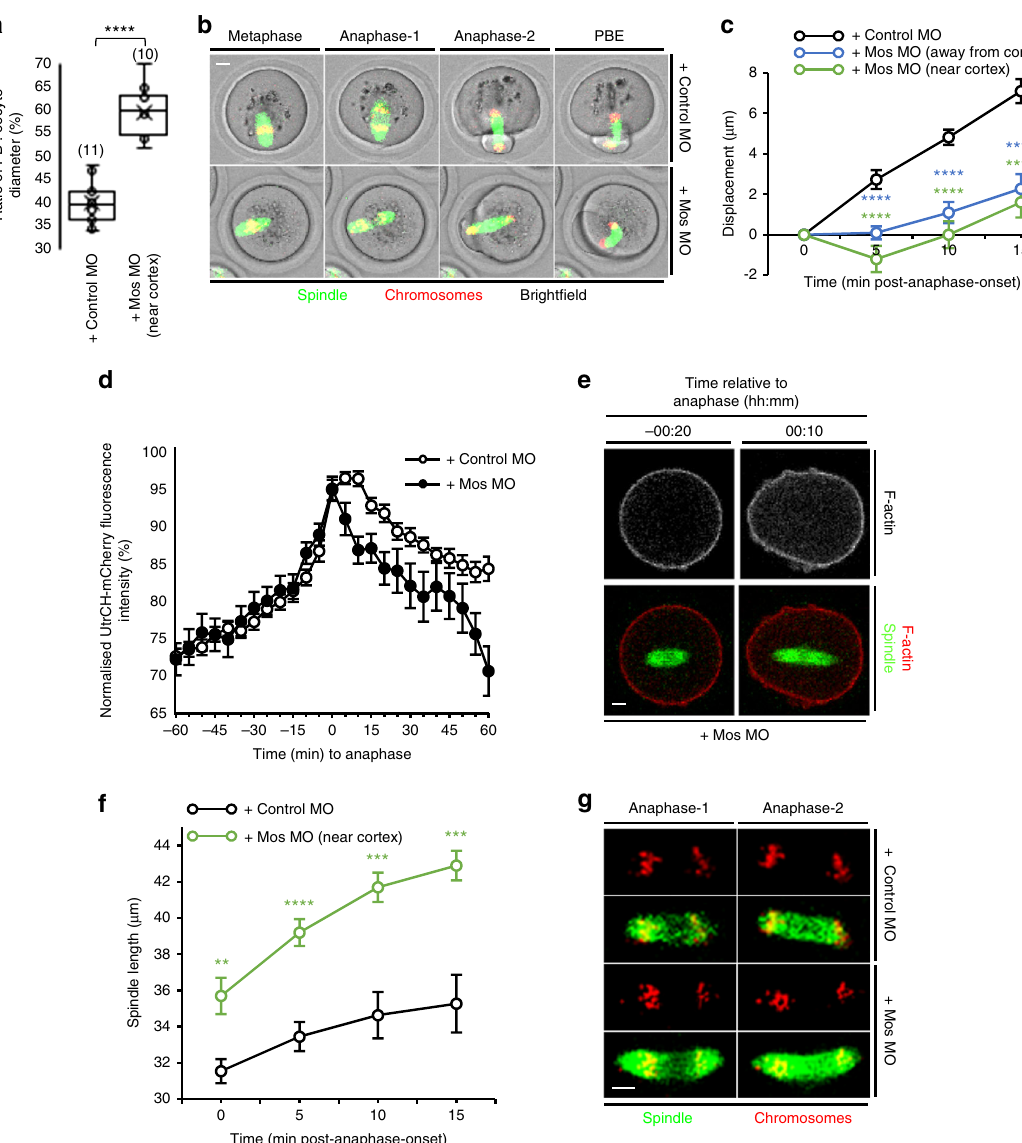
Fig. 7 Mos depletion impacts anaphase-spindle migration and spindle length. a Ratio of PB:oocyte diameter for mock-depleted oocytes and Mos-depleted oocytes having cortical-proximal spindles at the time of anaphase-onset. Oocyte numbers are shown in parentheses from a minimum of three independent experiments. b Large PB produced following Mos depletion despite the spindle being adjacent to the cortex at anaphase-onset (see Supplementary Movie 29). c Quanti fi cation of spindle displacement (due to the marked anaphase spindle elongation [see d ], midzone displacement rather than posterior pole displacement was quanti fi ed) between anaphase-onset and anaphase-completion for Mos- and mock-depleted oocytes ( n = 11). For Mos-depleted oocytes, results were grouped based on whether spindles underwent anaphase close to the oocyte centre (MosMO (away from cortex), n = 12) or close to the cortex (MosMO (near cortex), n = 10). d Cytoplasmic UtrCH-mCherry fl uorescence in relation to anaphase-onset for mock- and Mos-depleted oocytes ( n = 20 and n = 17, respectively). e Live Mos-depleted oocyte in which spindle undergoes anaphase close to the oocyte centre associated with increased cytoplasmic F-actin. f , g Changes in spindle lengths between anaphase-onset and anaphase-completion for live mock- and Mos-depleted oocytes ( n = 11 and n = 10, respectively). Times in panels are hours:minutes relative to anaphase-onset. Scale bars, 10 µ m. Two-tailed Student ’ s t test ( a , f ) or one- way ANOVA ( c ) used for statistical analysis. P values represented as ** P < 0.01, *** P < 0.001 and **** P <